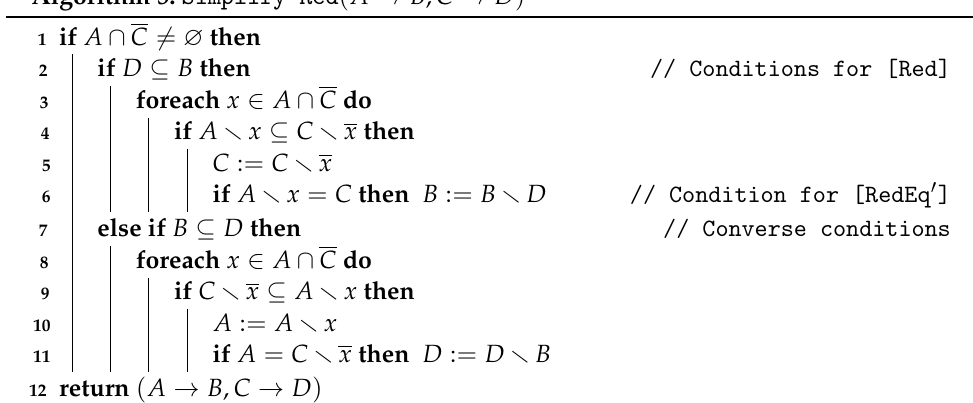
Algorithm 5: Simplify-Red ( A